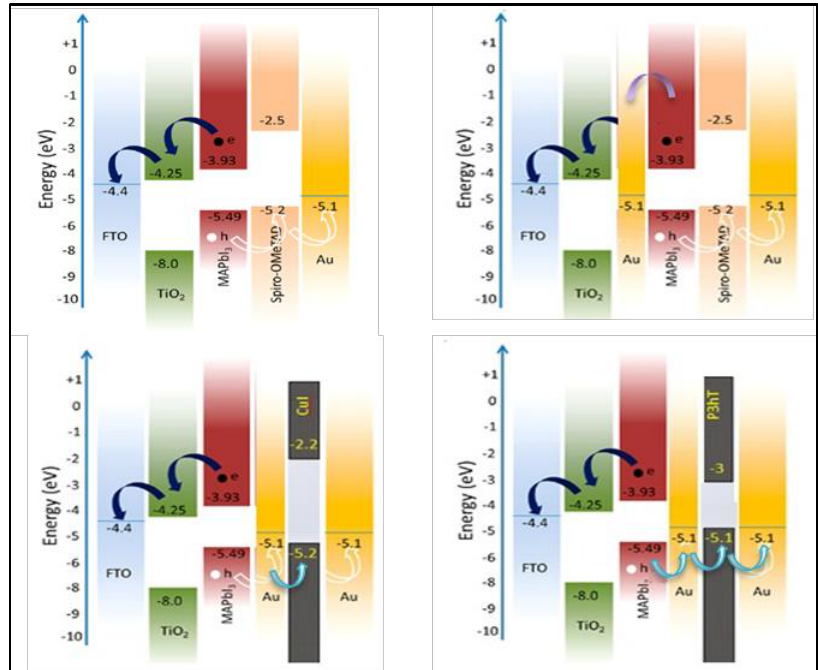
Figure 2: Energy diagram of a typical PSC using TiO absorber, and Spiro-OMeTAD as the HTM. FTO is the front contact, while gold is the back